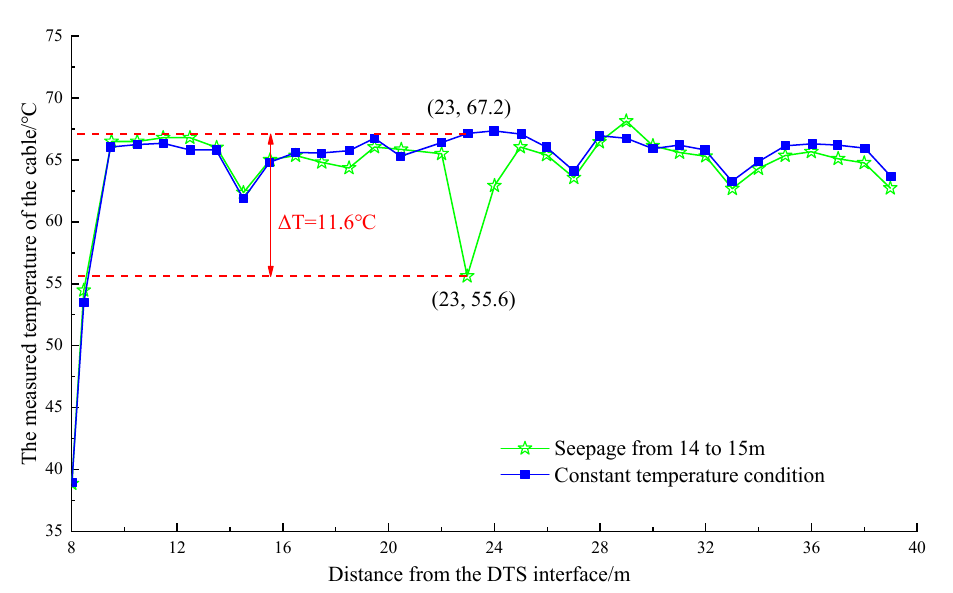
Figure 13. The temperature drop curve at the position of 14~15 m in the pipeline.